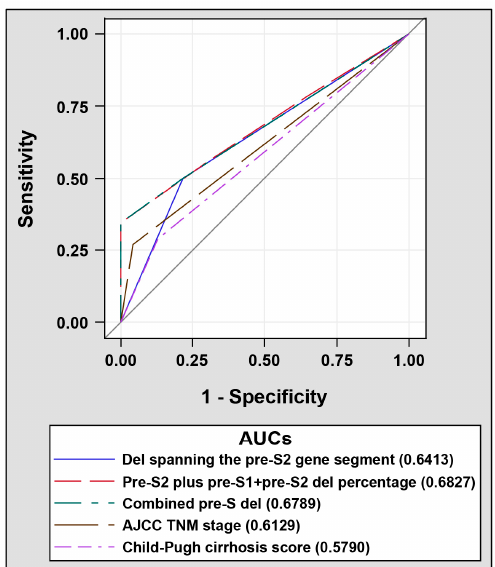
Figure 3. ROC curves of the selected prognostic factors in discriminating patients with HCC recurrence after surgical resection from those without. 52 patients with and 23 patients without HCC recurrence were analyzed. AUCs for selected prognostic factors, including deletions spanning the pre-S2 gene segment (solid blue line), the pre-S2 plus pre-S1 + pre-S2 deletions percentage (dashed red line), the combined pre-S deletions (dashed green line), the AJCC TNM stage (dashed brown line), and the Child-Pugh cirrhosis score (dashed purple line) were indicated in the plots.